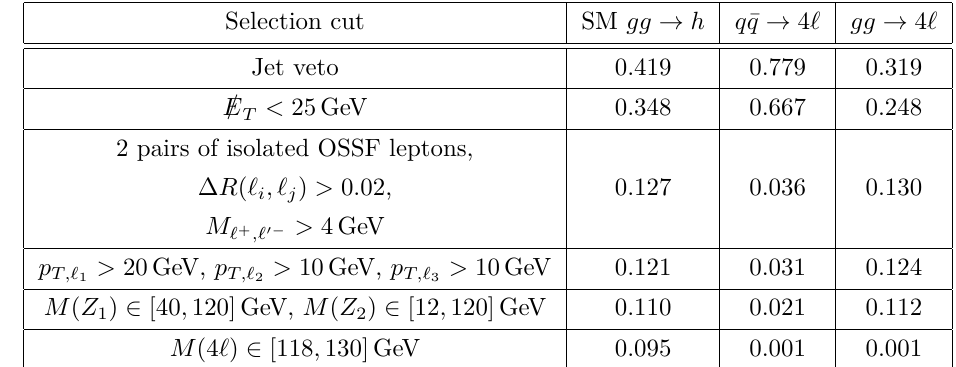
Figure 2 . Invariant mass distribution M (4 ‘ ) of the 4-lepton system after reconstruction of Z 1 Z 2 pairs. Stacked histograms for SM gg → h (red) signal, quark-initiated q ¯ q → 4 ‘ (light blue), gluon- initiated gg → 4 ‘ (dark blue), and Z/γ ∗ +jets (green) backgrounds, are normalised to the expected number of events at the HL-LHC. Except for the quark-initiated background, distributions are scaled ( 2 × ) for visualisation purposes.